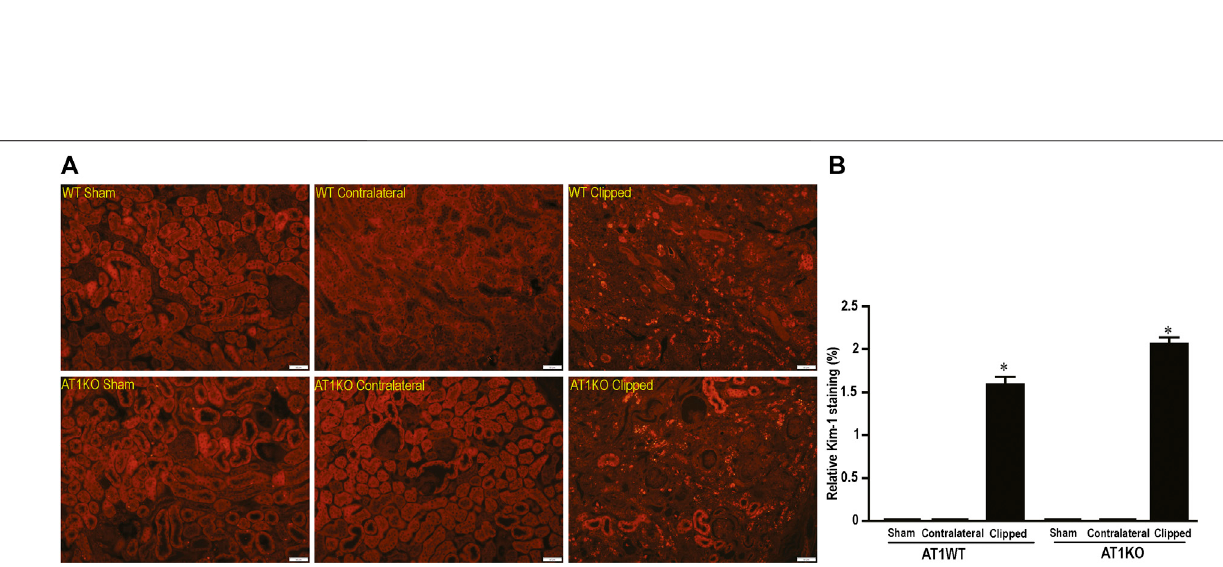
Frontiers in Pharmacology |